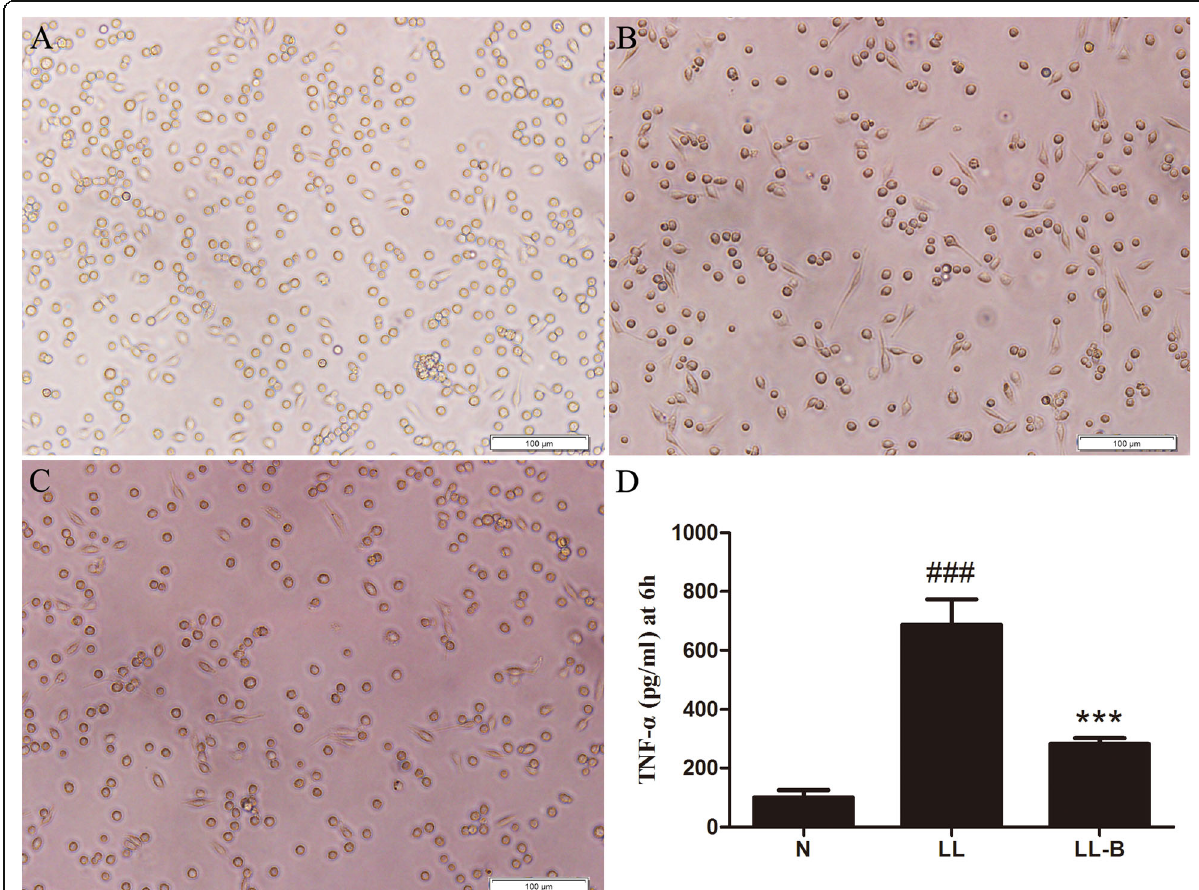
Fig. 5 Effects of BBR on LPS-induced inflammation in peritoneal macrophages. The LPS intervention time was 6 h. a Control group. b 0.1 μ g/ml LPS group. c 0.1 μ g/ml LPS + BBR group. d Level of TNF- α in the supernatant. N, normal control group. LL, Low LPS group; LL-B, Low LPS + BBR group; Compared with N group, ### P < 0.001; Compared with LL group, *** P <